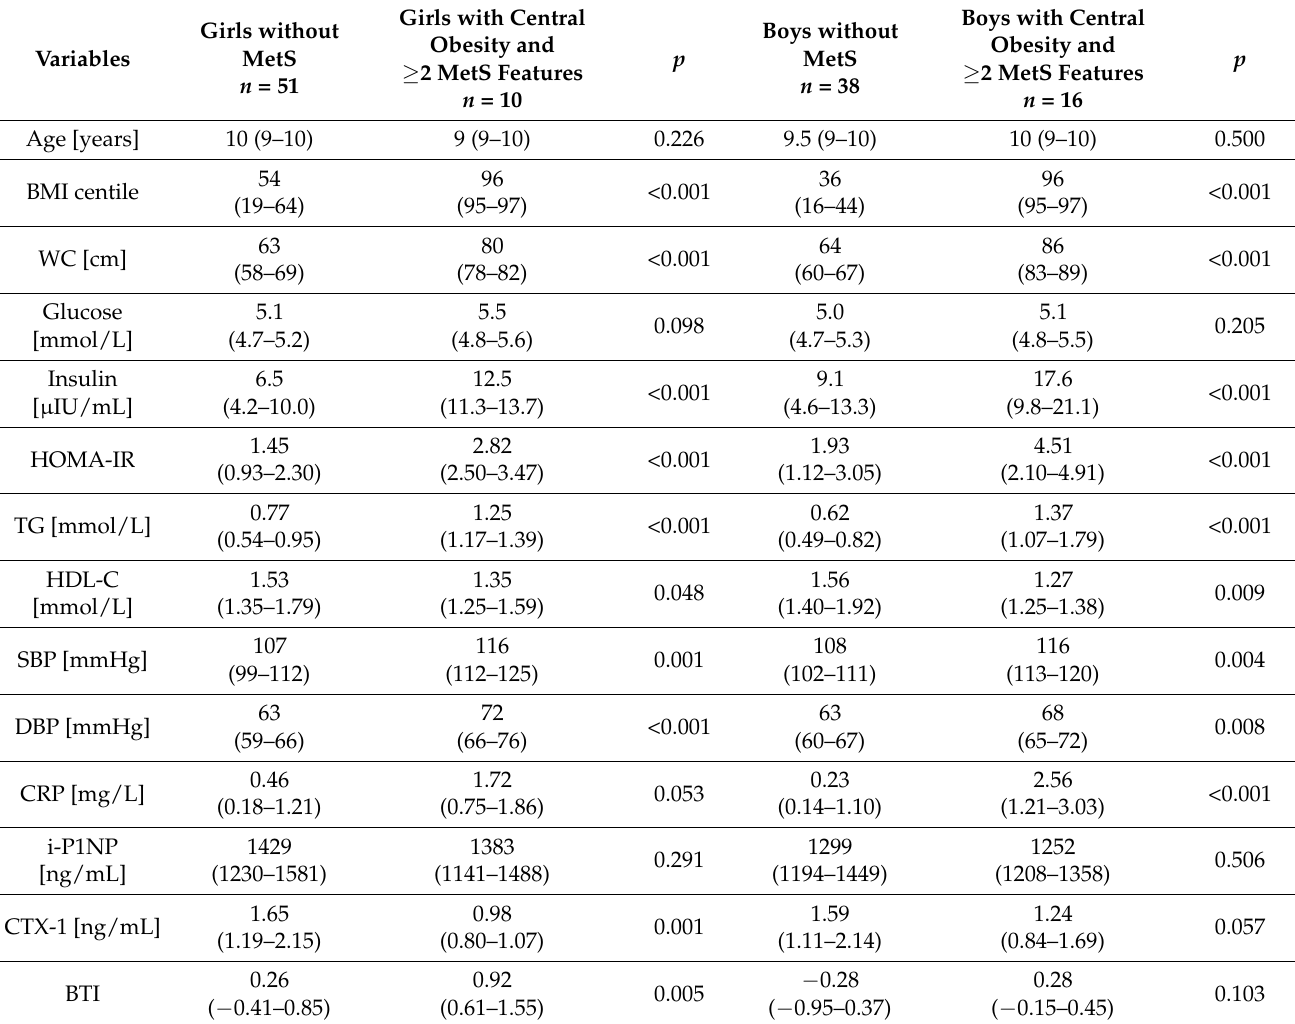
Table 1. Clinical and biochemical characteristics of the study